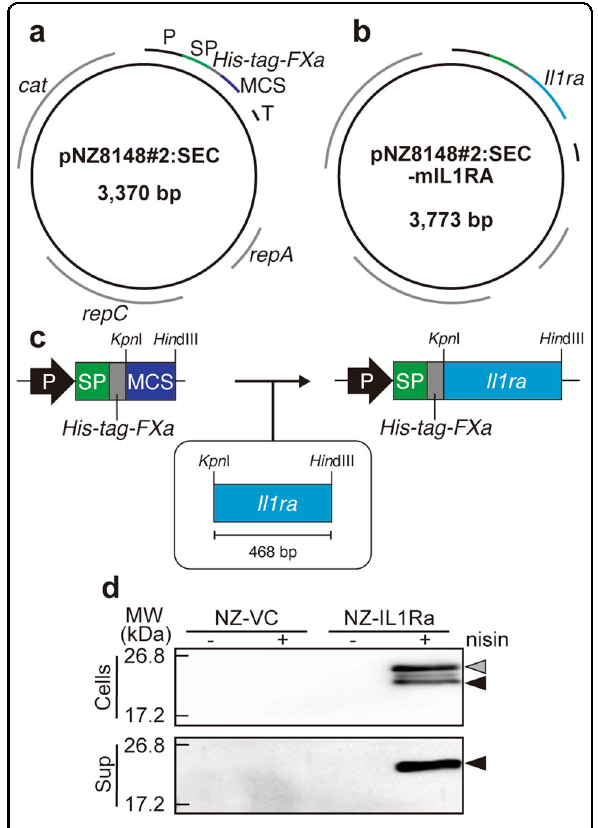
Fig. 1 Construction of an IL-1Ra gene expression vector and analysis of rmIL-1Ra expression. a Vector map of the lactococcal secretion vector pNZ8148#2:SEC. P, nisin A-regulated promoter; SP sequence of the signal peptide from the USP45 protein, His-tag DNA sequence encoding the 6× histidine tag, FXa DNA sequence encoding the Factor Xa recognition site, MCS multiple cloning site, T terminator, rep replication gene, cat chloramphenicol acetyltransferase gene; b vector map of pNZ8148#2:SEC-IL1Ra. mIL-1Ra , the MG1363-optimized DNA sequence encoding mIL-1Ra. c Scheme of the procedure for constructing the IL-1Ra gene expression vector. d NZ – VC or NZ-IL1Ra was cultured in the presence ( + ) or absence ( − ) of nisin (1.25 ng/mL) for 3 h to induce recombinant protein expression. In the cell fraction, bands corresponding to the sizes of the SP and rmIL-1Ra complex (gray arrowhead: 24.5kDa) and secretory rmIL-1Ra (black arrowhead: 21.8 kDa) were detected. A secreted rmIL-1Ra (black arrowhead: 21.8 kDa) band was also detected in the supernatant